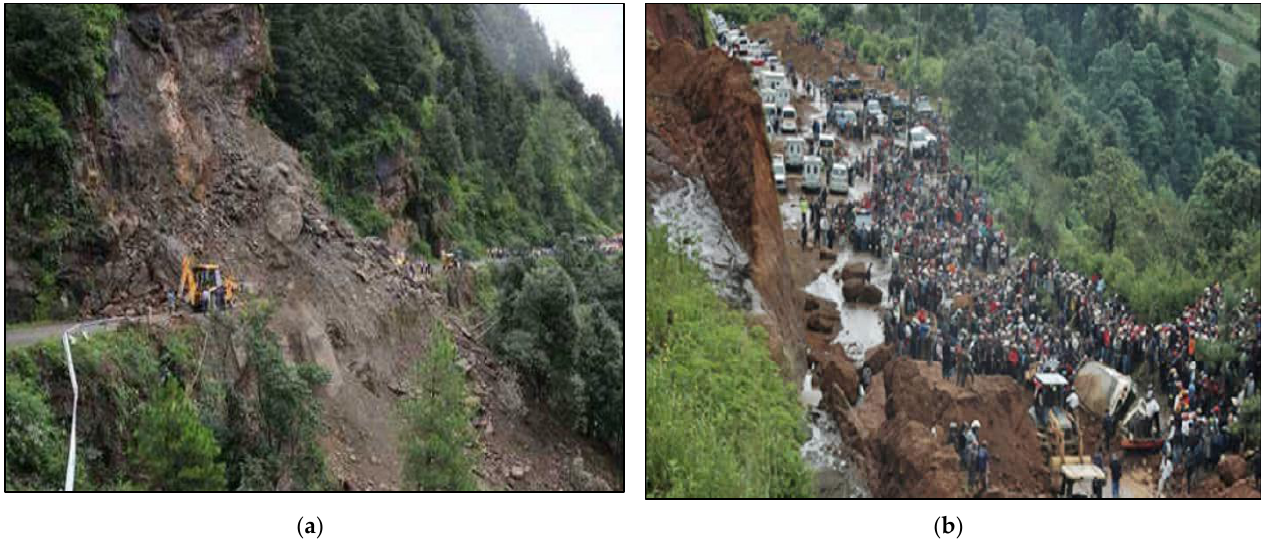
Figure 9. ( a ) Massive landslide blocks Jammu’s circular road adapted from source: Ref [67,68], ( b ) Landslide on Jammu Srinagar national Highway adapted from source: Ref [69].